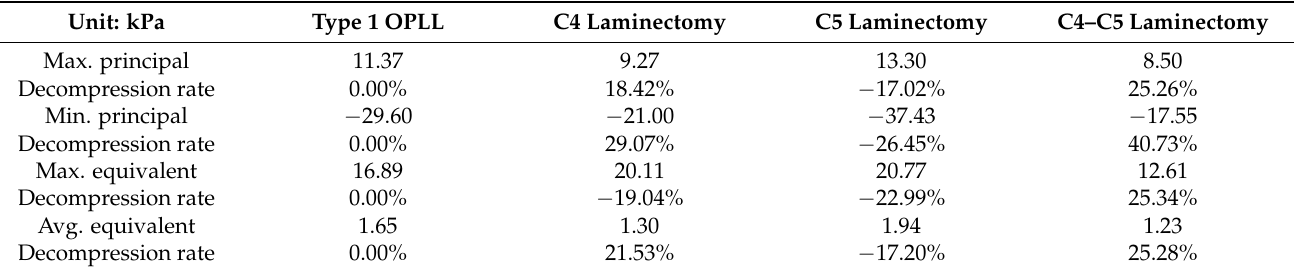
Figure 10. Flexion laminectomy simulation: ( a ) maximum and minimum principal stresses (kPa); and ( b ) maximum and average equivalent stresses (kPa). Table 7. Flexion laminectomy simulation spinal cord stresses: type 1 OPLL.